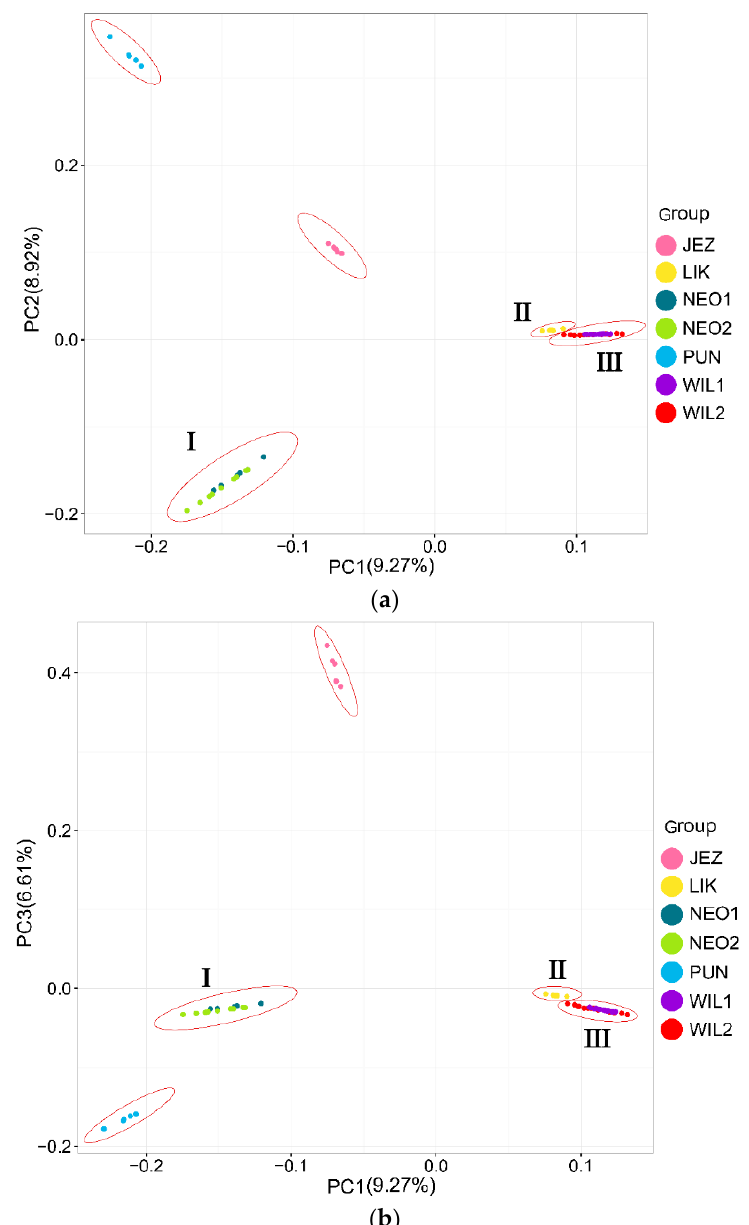
Figure 3. Principal component analysis of 60 spruce plants. ( a ) PC1 & PC2, ( b ) PC1 & PC3. The species abbreviations are the same as in Figure 1. Ⅰ , Ⅱ and Ⅲ are the three subgroups in Figure 1.